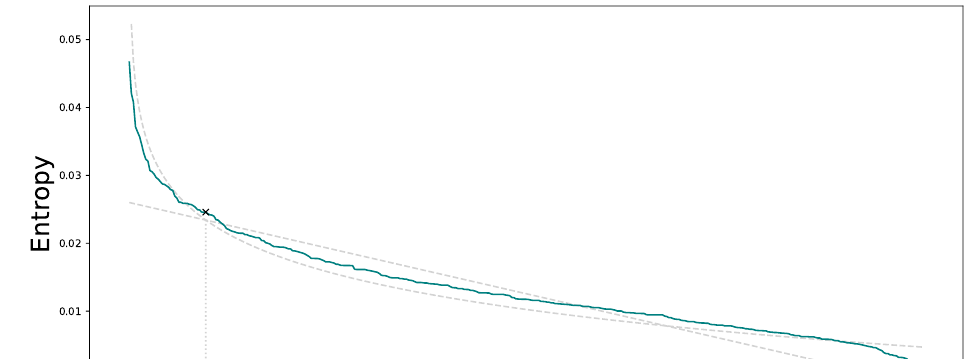
Figure 8. Entropy of households ( a ) H1 and ( b ) H2.